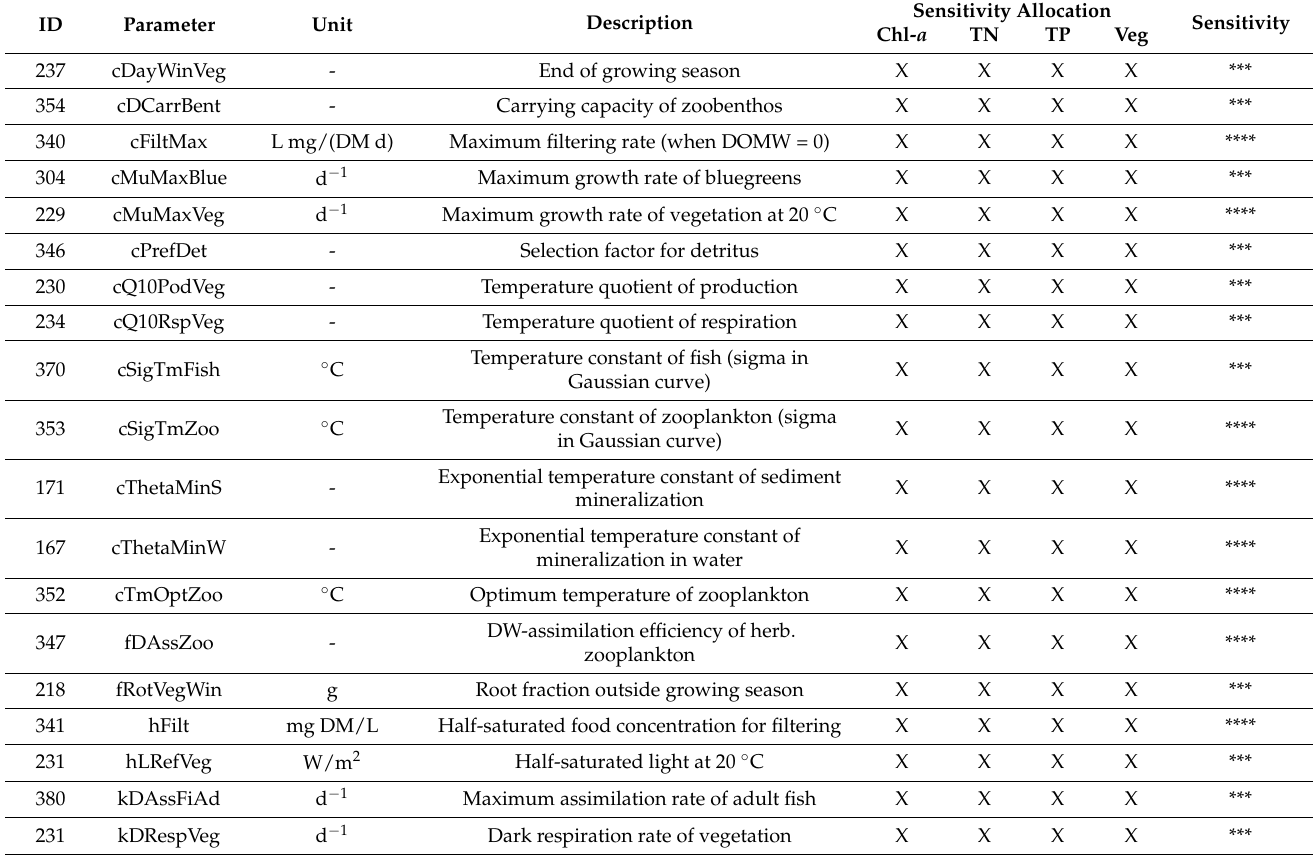
Table 2. Parameter calibration table. Chl- a : chlorophyll a ; DOMW: Total organic matter dry weight; DW: Dry weight; TN: total nitrogen; TP: total phosphorus; Veg: vegetation. An X under sensitivity allocation denotes if the parameter was identified as sensitive for the given water quality variable according to the 90th percentile criteria. Sensitivity illustrates the summarized and ranked normalized sensitivity for each parameter across all water quality variables. **** and *** indicate high